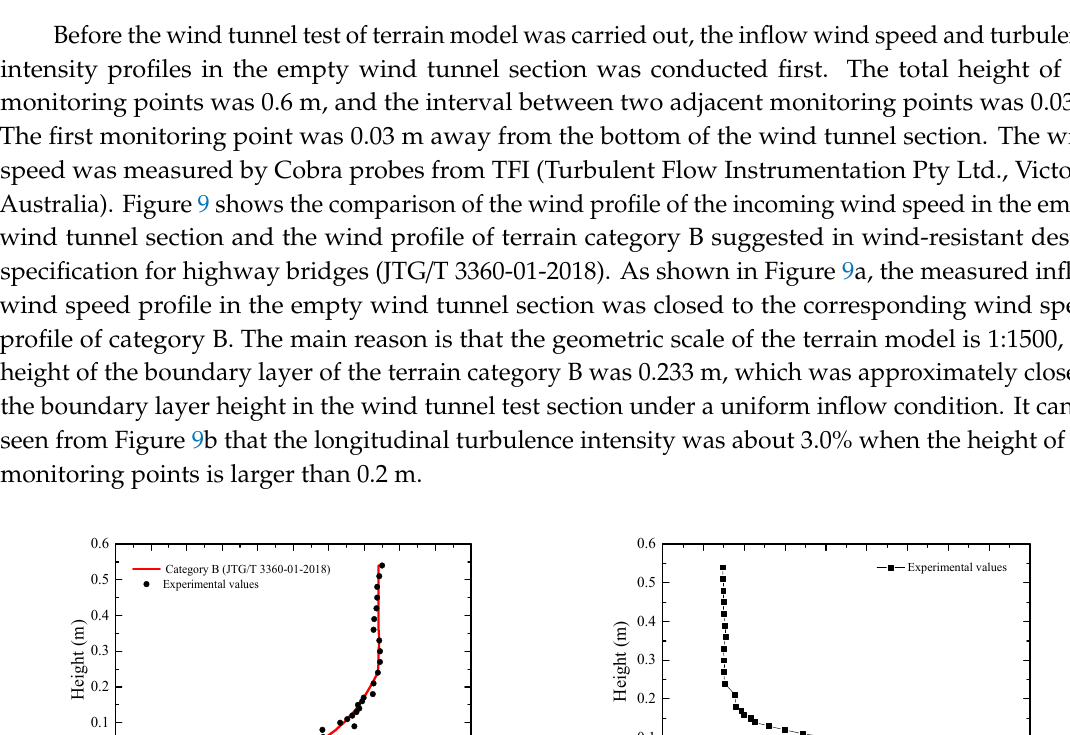
Figure 8. Mountainous terrain model with/without BTS in wind tunnel. ( a ) Terrain model without BTS; ( b ) Terrain model with BTS.